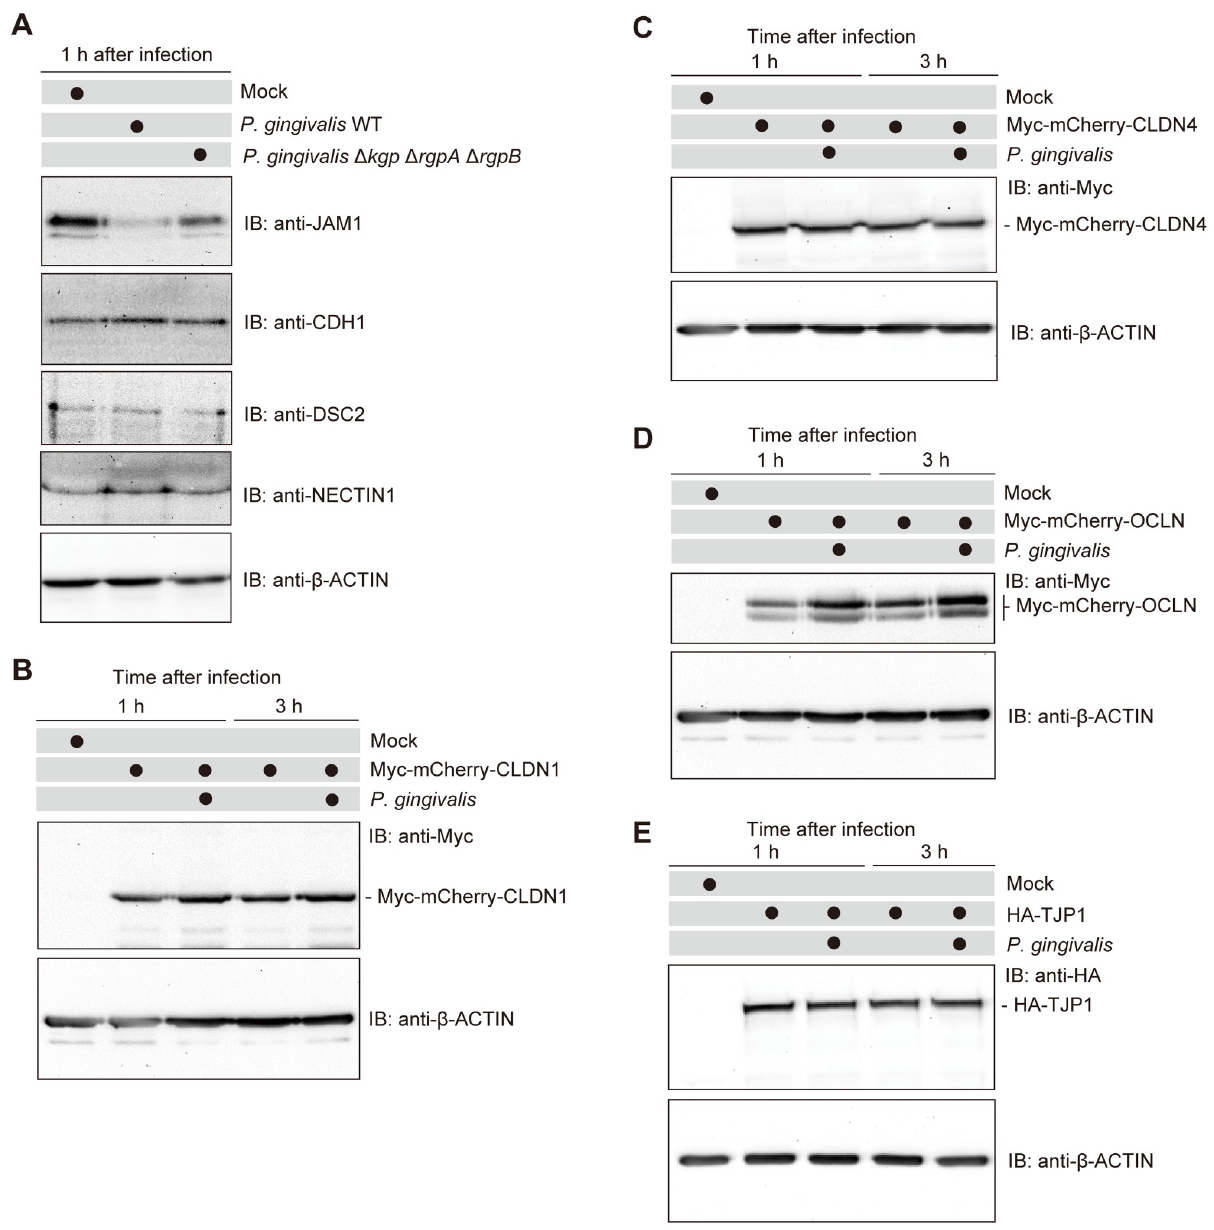
Fig 1. P . gingivalis gingipains degrade JAM1 in IHGE cells. (A) IHGE cells were infected for 1 h with P . gingivalis WT or the Δ kgp Δ rgpA Δ rgpB mutant at an MOI of 100. The cells were then analyzed by immunoblotting with the indicated antibodies. (B–E) IHGE cells were transiently transfected with plasmid encoding Myc-mCherry-CLDN1 (B), Myc-mCherry-CLDN4 (C), Myc-mCherry-OCLN (D), or HA-TJP1 (E). After 48 h of incubation, cells were infected with P . gingivalis at an MOI of 100 for 1 or 3 h. The cells were then analyzed by immunoblotting with the indicated antibodies. β - actin was used as a loading control. IB,